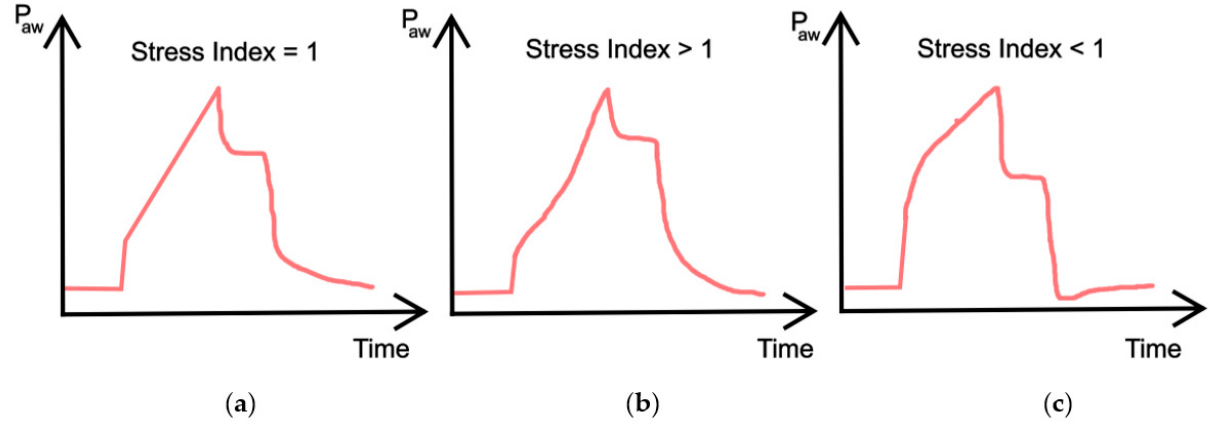
Figure 6. ( a ) Linear relationship between pressure and time indicating no recruitment or overdis ‐ tention; ( b ) Concave curve indicating overdistention; ( c ) Convex curve indicating recruitment dur ‐ ing the breath.